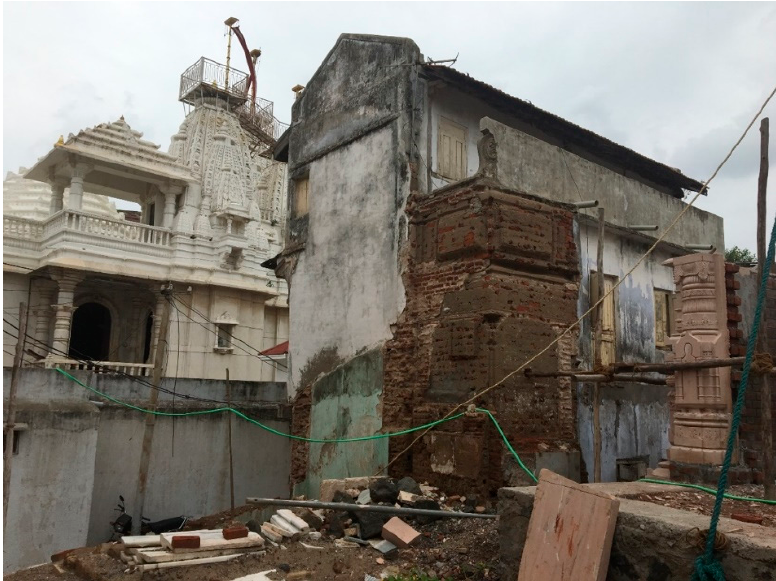
Figure 10. The remains of a house being torn down for the construction of a Ś vet ā mbara temple in the Ś r ī m ā ḷ ī P ō ḷ in Bharuch, Gujarat. July 2016.